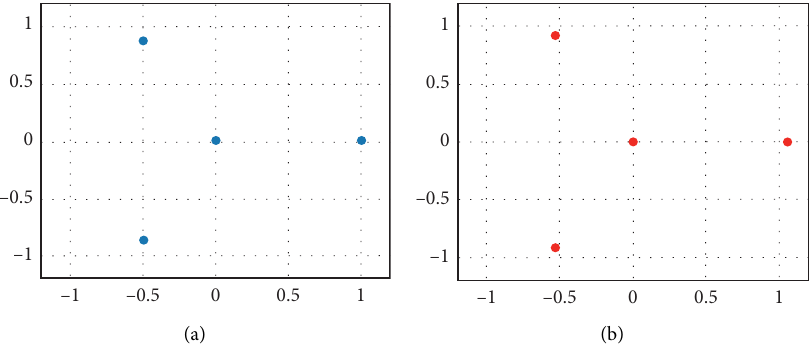
Figure 2: (a) Normal (3, 1) and (b) PS (3, 1) signal constellations.